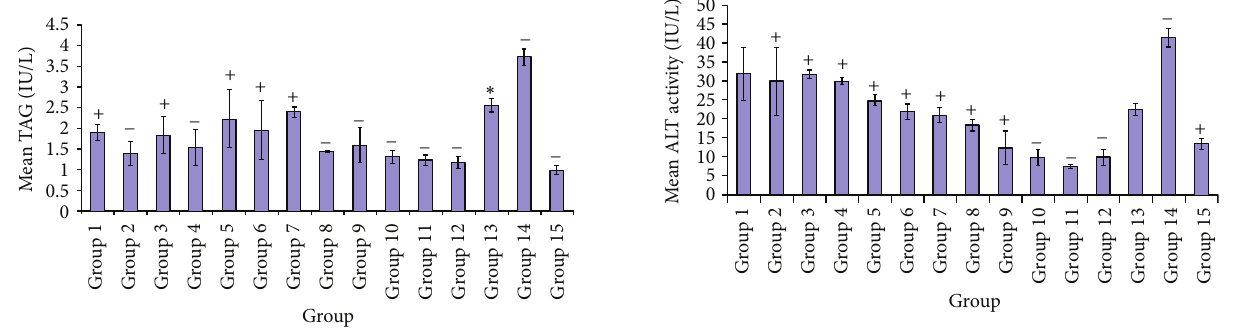
Figure 5: Comparative effect of the various plant extracts on triglycerides.